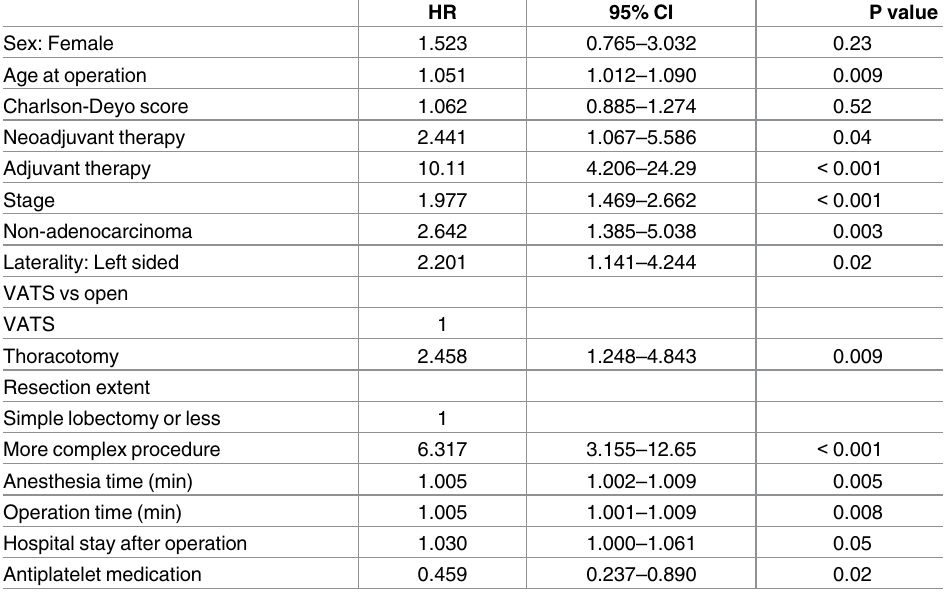
Table 3. Univariable Cox proportional hazard regression of selectedrisk factors for vascularstump thrombus